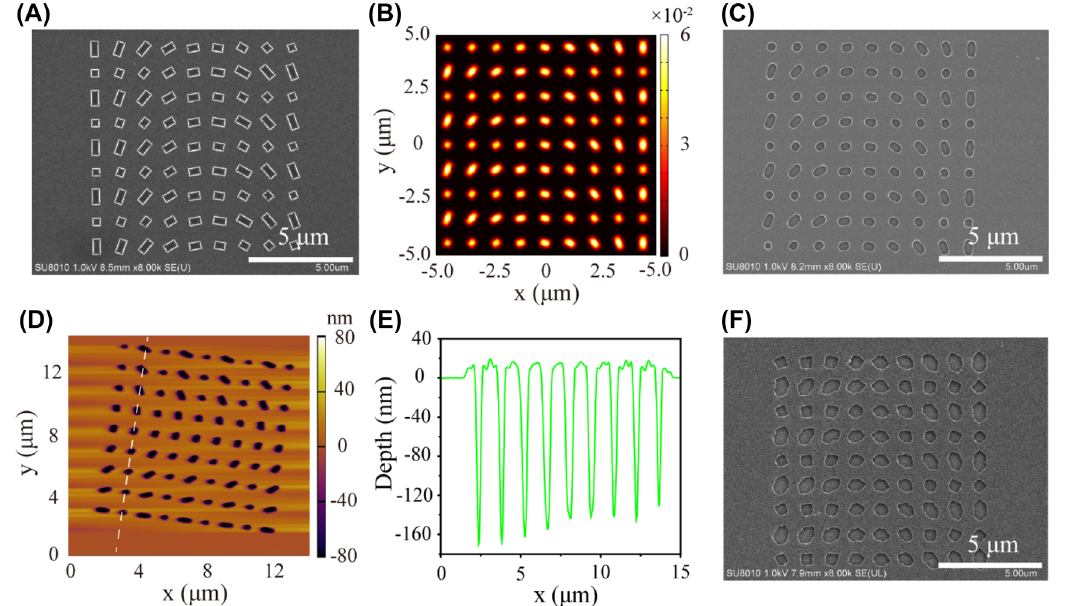
Figure 6: Experimental results of a mask with patterns over large area. (A) SEM image of a mask constructed with aperiodic rectangles. (B) Normalized intensity distributions extracted from the position of 100 nm- depthPR. (C,D)SEM andAFMimages of thepatternformedinPR. (E)Correspondingdepthpro fi lealong thedashedlinein(D).(F) SEMimages of the PR patterns in control